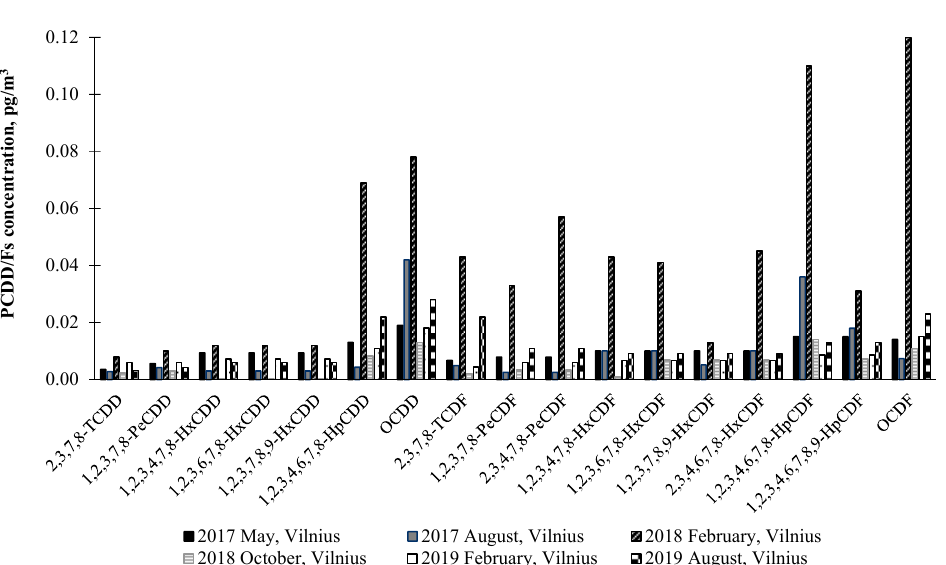
Figure 4. Atmospheric PCDD/F in urban regions of various countries. Dashed lines represent the accepted limits on presence of PCDD/F in air in various countries.